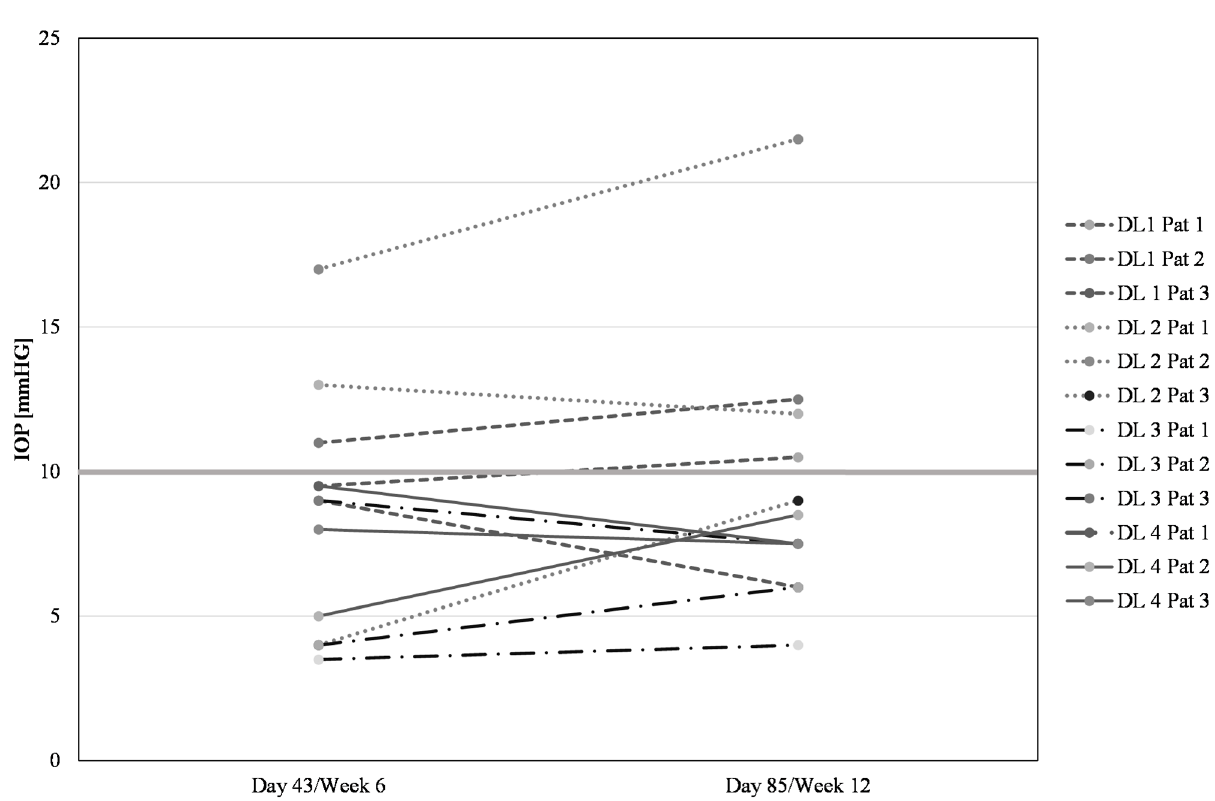
Fig 2. Postoperative intraocular pressure on Day 43 and Day 85 per patient. Bar indicates10 mmHg IOP level threshold not exceeded by DL 3 and DL 4 patients.